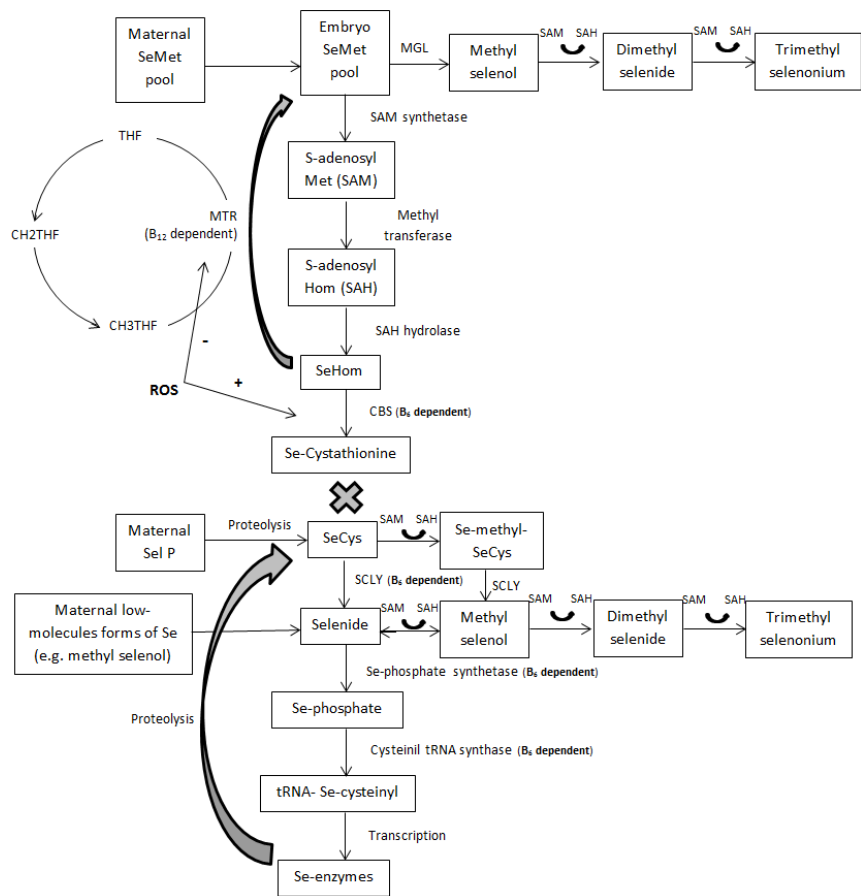
Figure 2. Embryo transmethylation and transsulfuration pathways of selenium (similar for sulfur counterparts) and possible maternal selenium transfer routes. Maternal selenomethionine (SeMet) is transferred to the embryo and may be methylated to methyl selenol by methionine γ lyase (MGL) or demethylated to selenohomocysteine (SeHom). SeHom may follow remethylation back to SeMet or transsulfuration to form selenocystathionine because the enzyme cystathionine γ lyase (CGL) that catalyzes the synthesis of selenocysteine (SeCys) from selenocystathionine is inactive in embryos. Pre ‐ formed SeCys may be available after maternal selenoprotein P proteolysis in the placenta. Through the actions of selenocysteine lyase (SCLY), selenide is formed. Selenide may be methylated and excreted or phosphorylated and its selenium (Se) incorporated into tRNA Se ‐ cysteinyl with further translation to Se ‐ enzymes. THF = tetrahydrofolate; CH2THF = 5,10 ‐ methylene ‐ THF; CH3THF = 5 ‐ methyl ‐ THF; MTR = methionine synthase; CBS = cystathionine β synthase; ROS = reactive oxygen species.